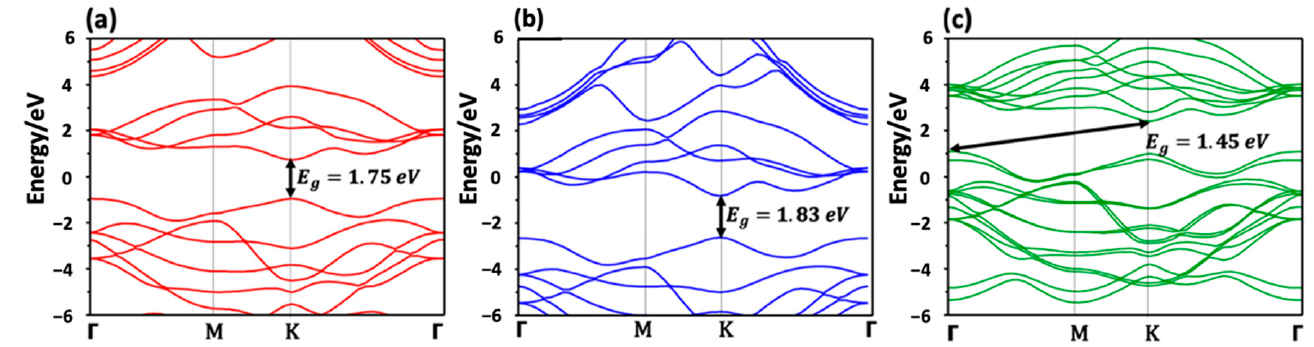
Figure 7. DFT computed electronic bands structure for monolayer ( a ) MoS 2 , ( b ) WS 2 and ( c ) Mo x W 1-x S 2 .